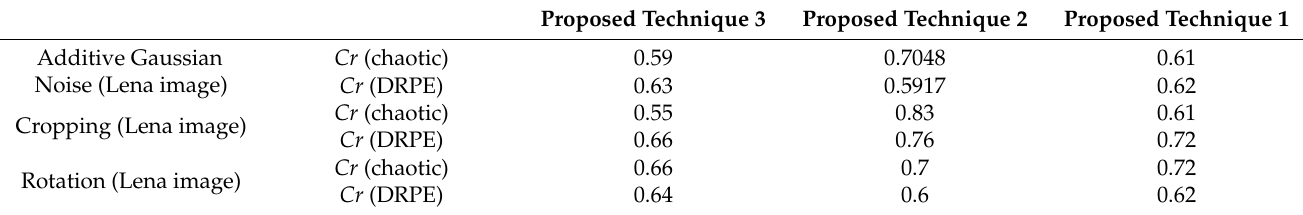
Table 17. The comparison among the recovered watermark after applying